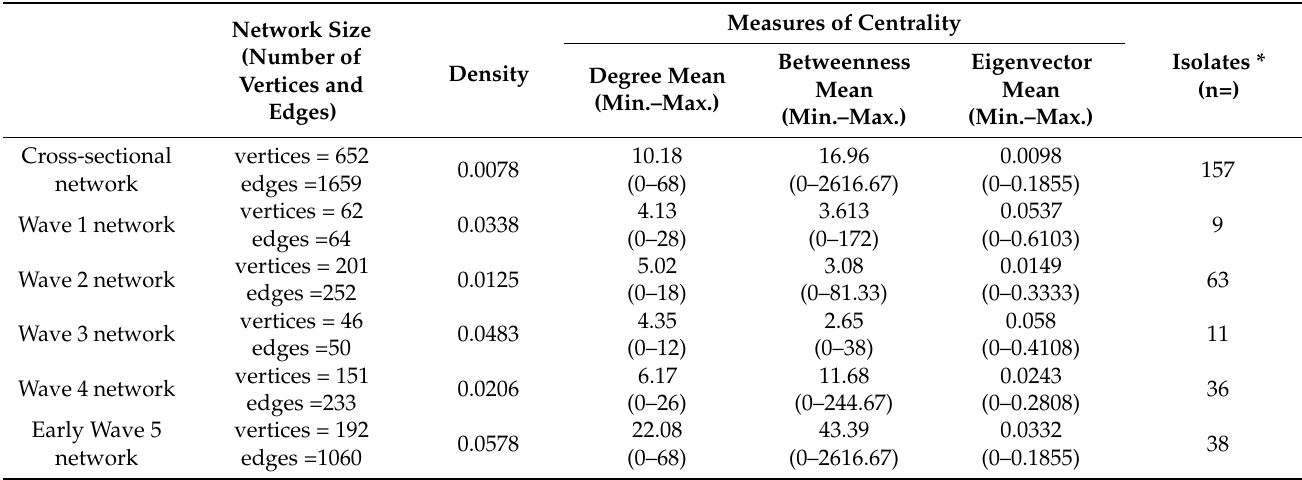
Table 4. Descriptive Statistics of Network